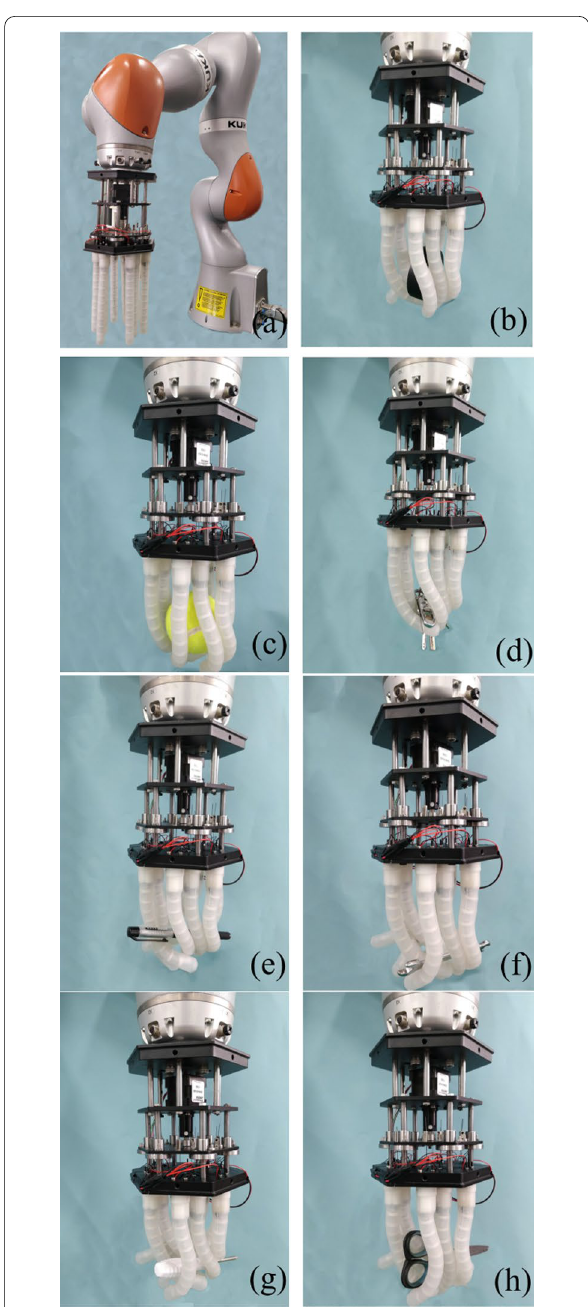
Figure 9 Universal grasp experiments: ( a ) KUKA robotic manipulator, ( b ) Tape, ( c ) Tennis ball, ( d ) Keys, ( e ) Pen, ( f ) Wrench, ( g ) Screwdriver, ( h ) Scissors